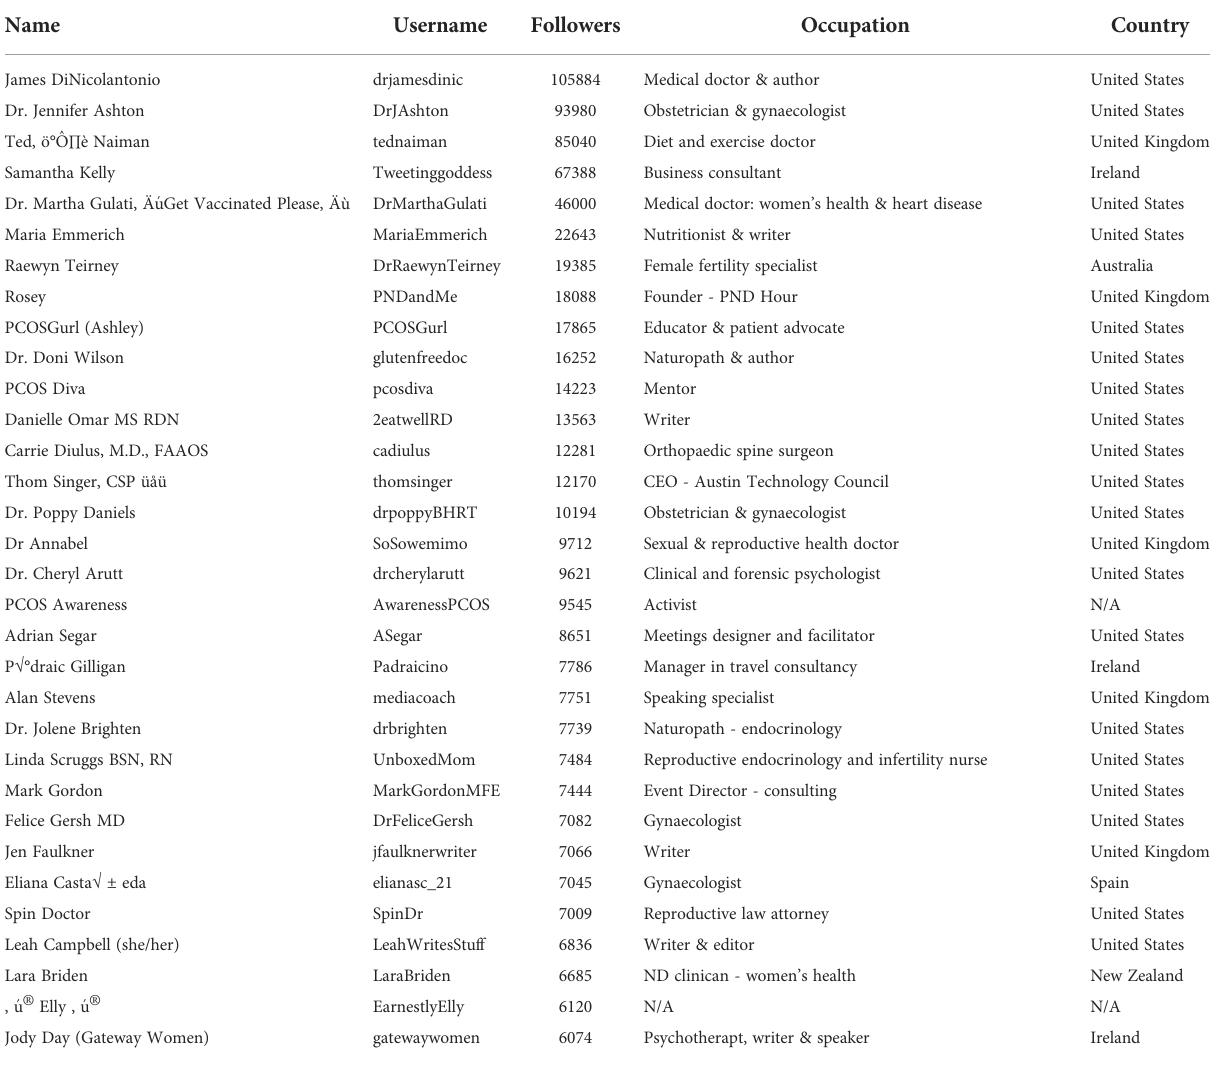
TABLE 1 Top 100 in fl uencers for PCOS on social media